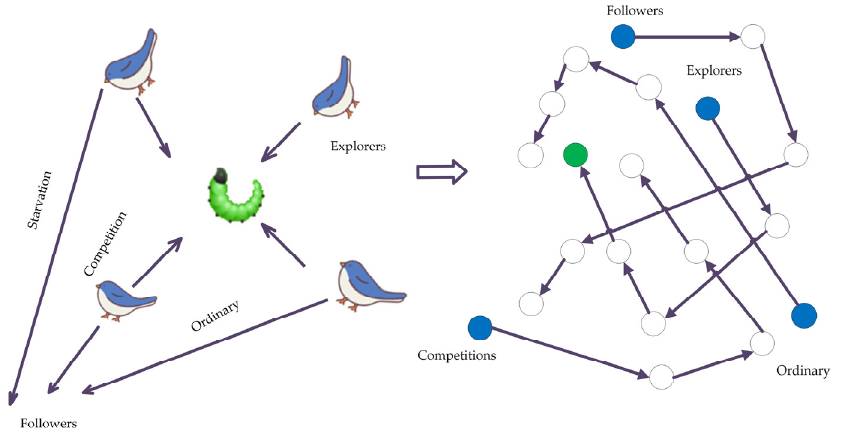
Figure 4. Sparrow search algorithm procedures.